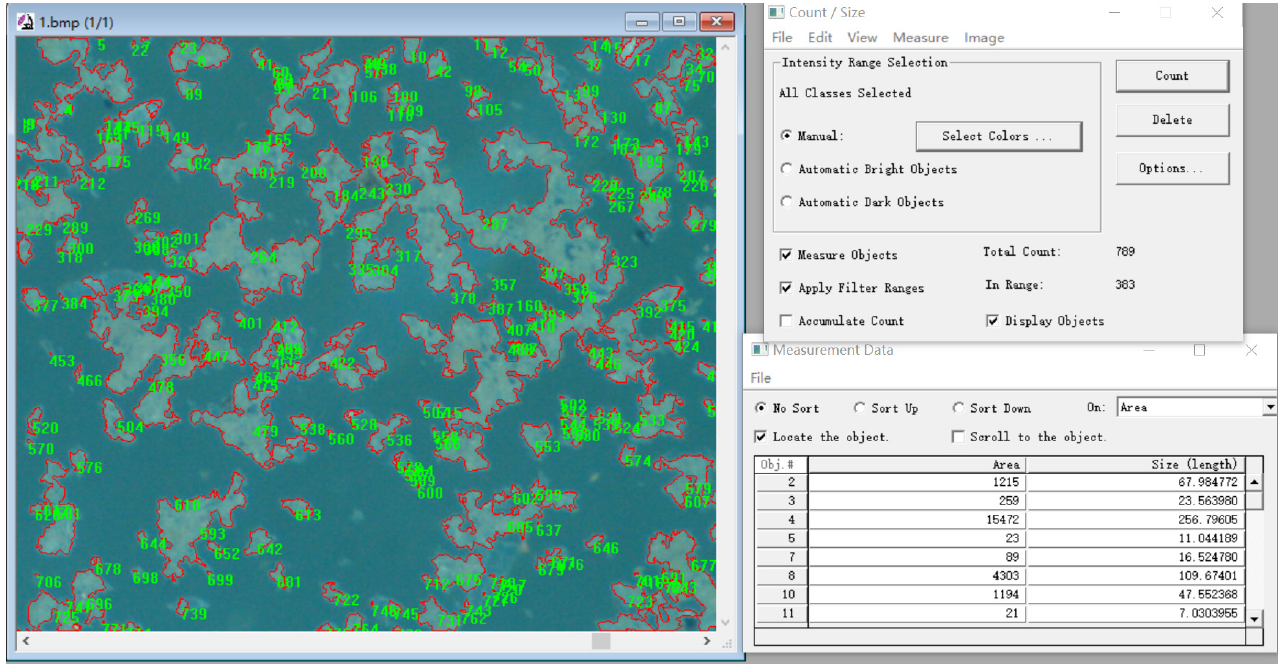
Figure 3. Image of flocs processed by Image-Pro Plus 6.0.